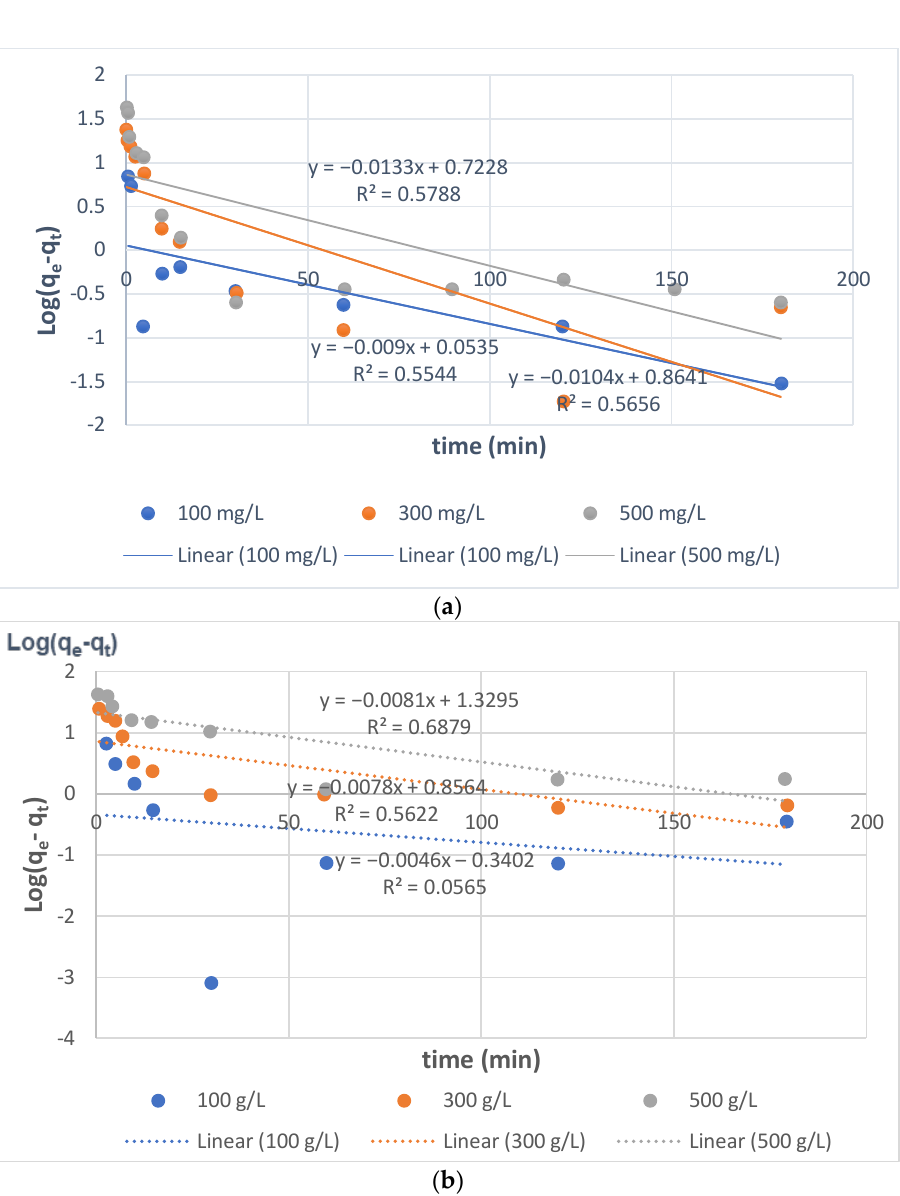
Figure 7. Log (𝑞 𝑒 − 𝑞 𝑡 ) vs. t dependencies determined from the linear form of the PFO model in Figure 7. Log ( q e − q t ) . vs. t dependencies determined from the linear form of the PFO model in ( a ) ( a ) Yellow GL-SBR and ( b ) Yellow GL-WBR systems. Yellow GL-SBR and ( b ) Yellow GL-WBR